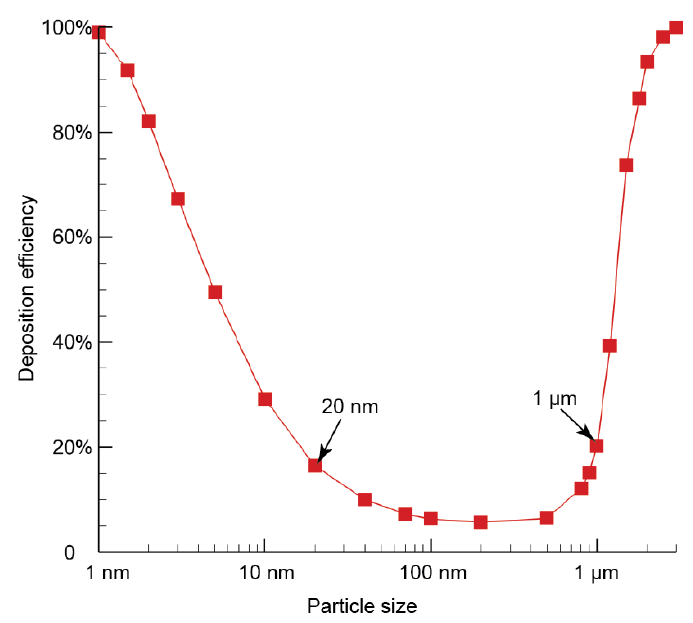
Figure 7. The overall particle deposition efficiency profile in a rat nasal passage. This deposition curve was reproduced from the authors’ previous work [29].